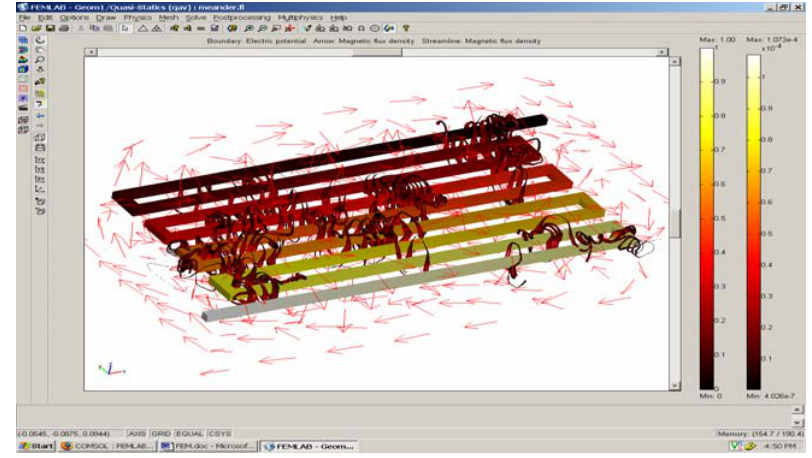
Figure 12. Solved meander type